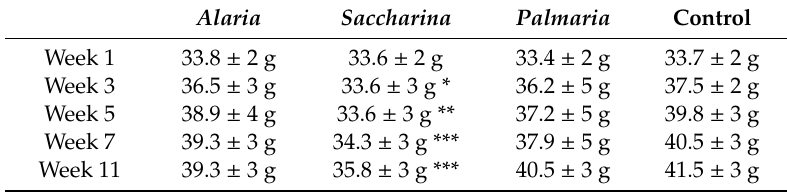
Table 3. Bodyweight in grams (g) at week 1, 3, 5, 7, and 11 of the KK-Ay mice measured fed diets supplemented with Alaria esculenta , Saccharina latissima , Palmaria palmata , or chow. Values